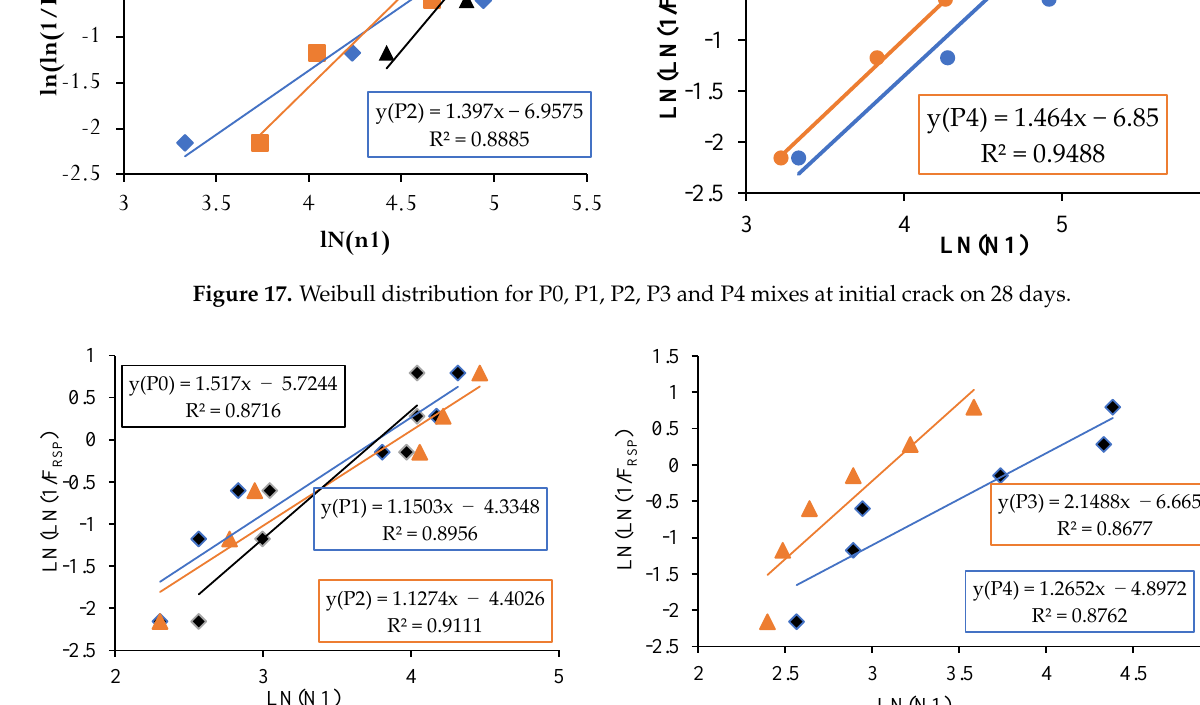
Figure 21. Weibull distribution for P0, P1, P2, P3 and P4 mixes at ultimate on 7 days. Table 6. Weibull distribution parameters and regression coefficients. Mix Identifica- tion